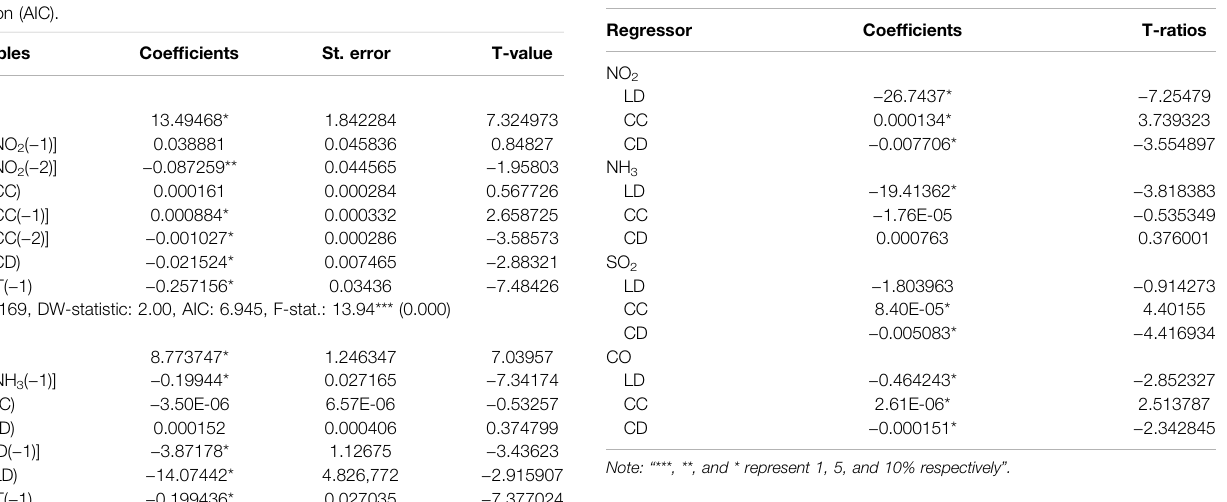
TABLE 5 | ARDL long-run form and bound test